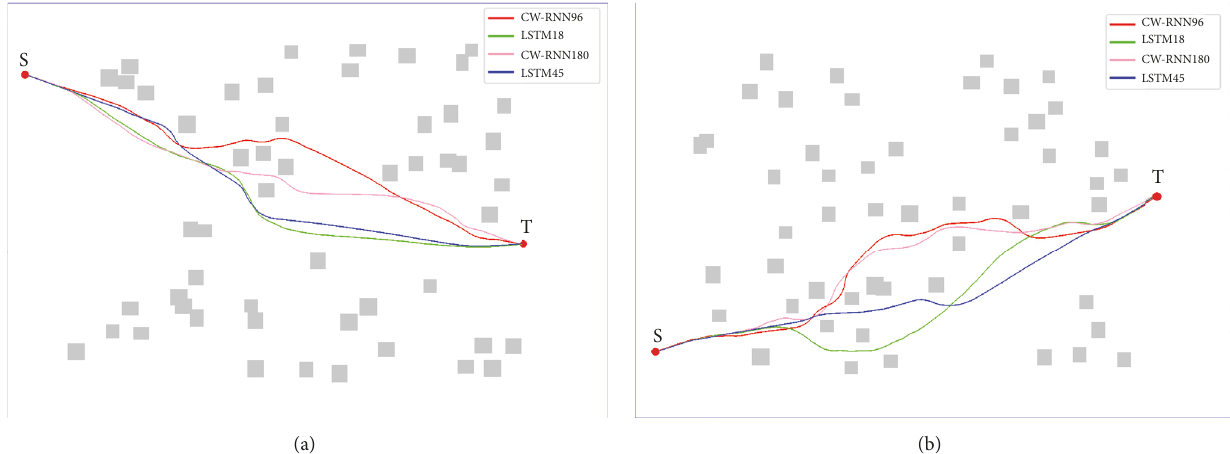
Figure 6: Online planning results of four obstacle avoidance algorithms of UUV in simulation test cases 1(a) and (b).